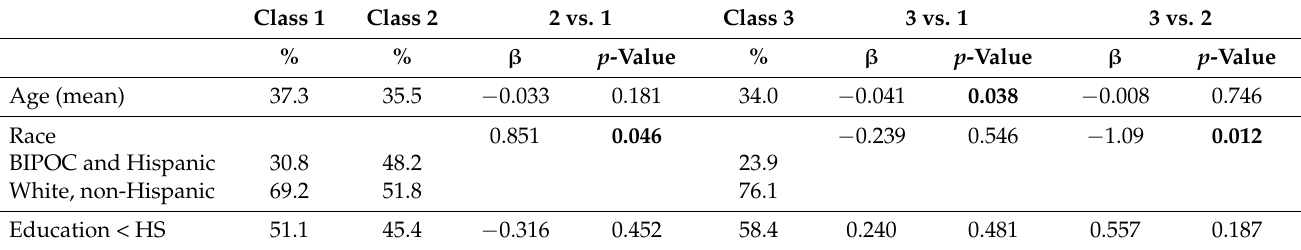
Table 4. Distribution of sociodemographic characteristics by latent class membership ( n =